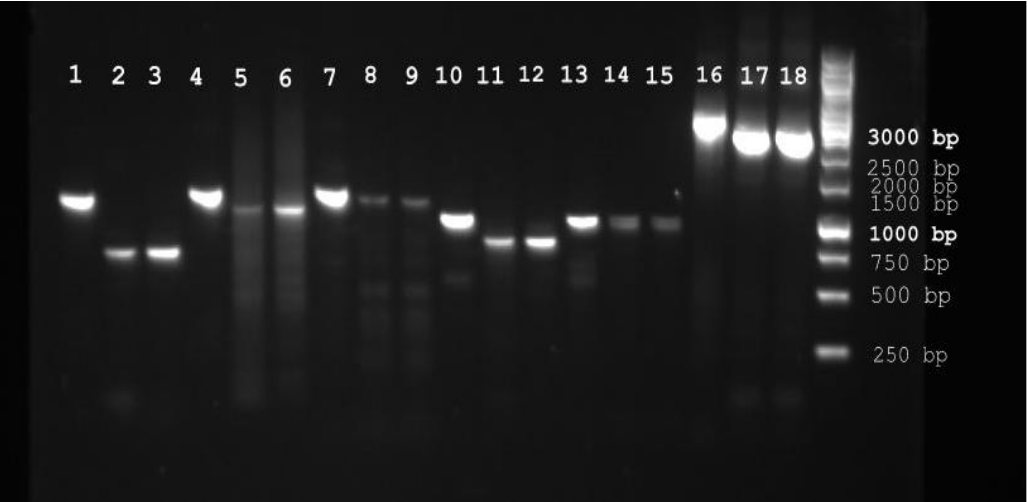
Figure 1. Electrophoretic profiles of obtained PCR and RT-PCR products for SOD and CAT genes from Chaetomium thermophilum var. dissitum (sequenced in this study). Agarose gel (0.9%) was run in TAE buffer (details in Section 2.3). Lane 1 — genomic DNA coding for CthedisCuZnSOD1, lane 2 — corresponding cDNA CthedisCuZnSOD1 control sample, lane 3 — cDNA CthedisCuZnSOD1 sample